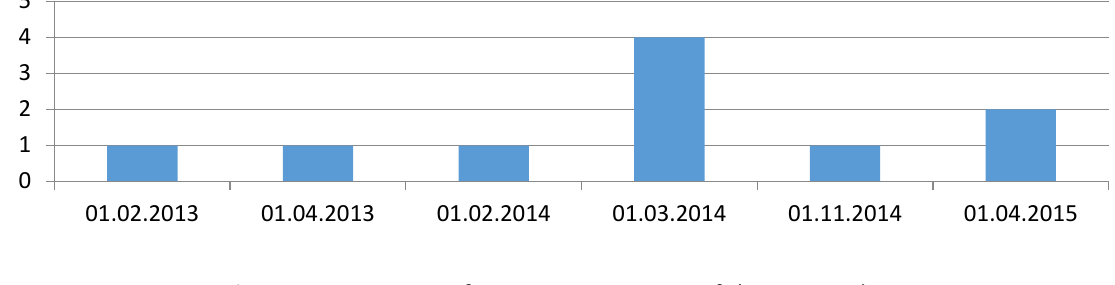
Figure 7. Frequency of overreactions, case of the PFTS index over the period 2013–2015 (monthly data)